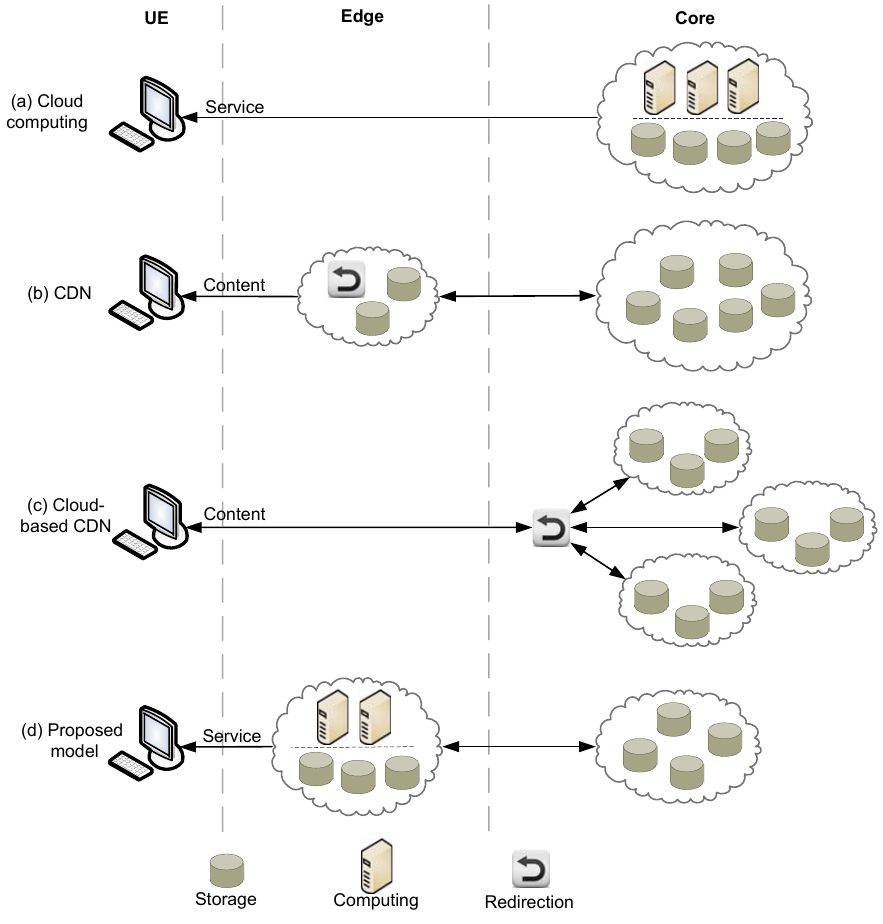
Figure 6. High-level architecture of different content/service delivery